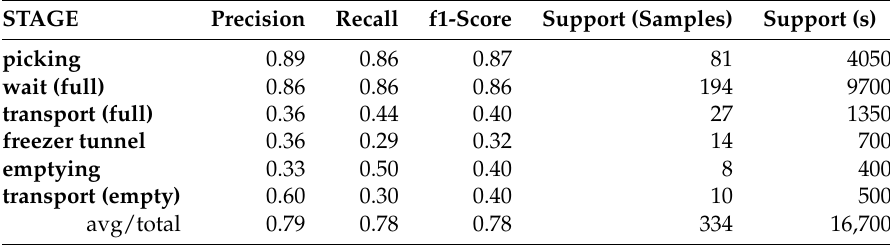
Table 2. Performance of the KNN algorithm using the data from the independent node. STAGE Precision